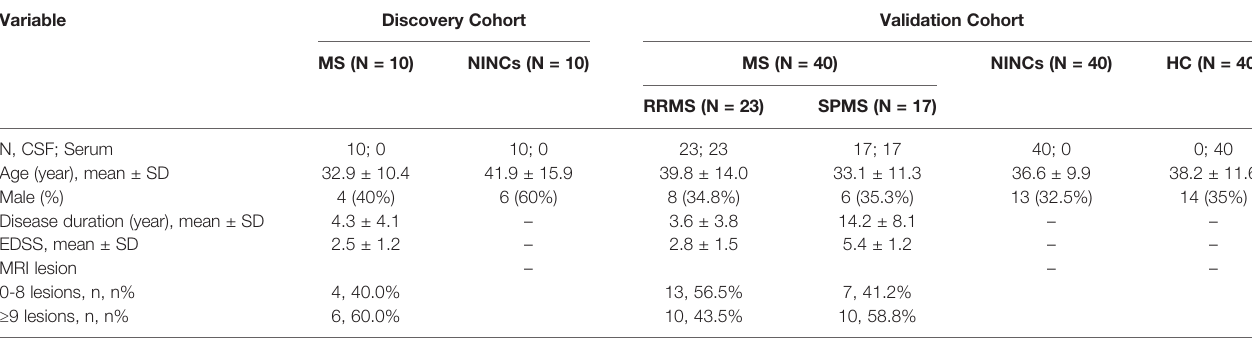
TABLE 1 | Demographic and clinical data for the participates included in the study. Variable